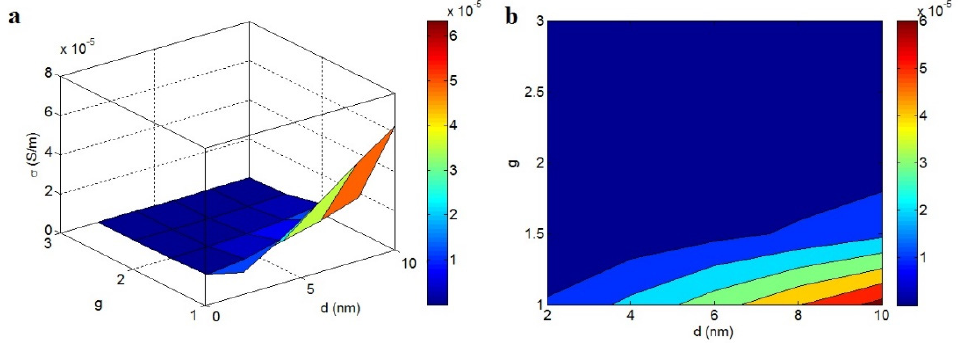
Figure 6. Disparities of conductivity at different ranks of d and g : ( a ) 3D and ( b ) 2D configurations.